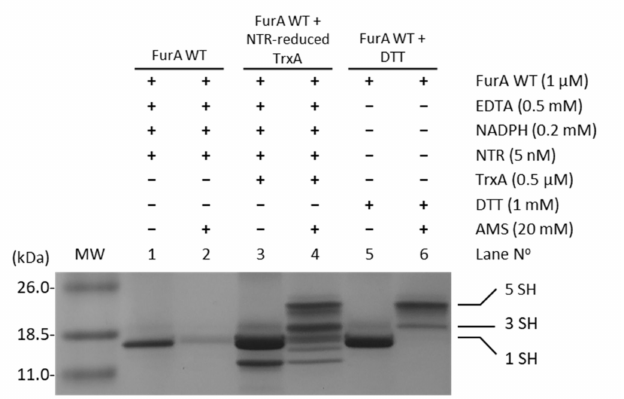
Figure 3. Reduction of FurA by TrxA. FurA WT (1 µ M) was incubated with 0.5 µ M TrxA in the presence of 0.2 mM NADPH, 0.5 mM EDTA, and 5 nM NTR to assess its reduction by NTR-reduced TrxA. FurA was also incubated with 0.2 mM NADPH and 5 nM NRT to determine whether NADPH- reduced NTR affected its redox status with 1 mM DTT as a positive control for protein reduction. Proteins were then precipitated with 10% ( w / v ) TCA, incubated with 20 mM AMS, loaded on non-reducing 15% SDS–polyacrylamide gels, and stained with